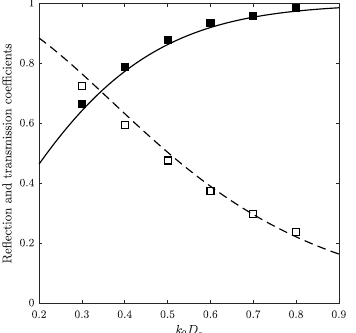
Figure 3. Wave scattering by a surface obstacle above a solid bed: reflection ( (cid:4) ; solid line) and transmission ( (cid:3) ; dashed line) coefficients. Symbols: present numerical results. Lines: analyti- cal predictions reported in the literature [7]. k 0 represents the wavenumber of incident waves. ( d , D o , L o , d m ) = ( 0.8,0.4,0.4,0 ) m are used in this example. See Figure 1a for the problem